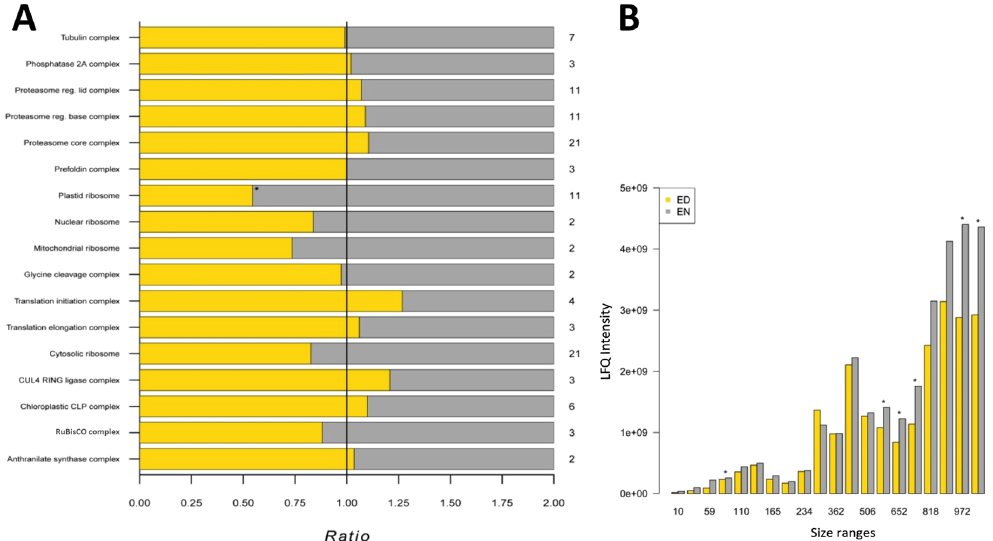
Figure 8. Arabidopsis complexome at the ED and EN. The relative abundances of protein complexes from the GO-Slim database were compared at the ED and EN. Ratios of the AUC from protein complex subunits identified in ED and EN were calculated and averaged for proteins belonging to the same complex. ( A ) The number of proteins the complex is composed of. ( B ) A barplot of the total abundance of ribosomal proteins found in each fraction of the gel. The analysis was performed for all overlapping ribosomal proteins that were present in both